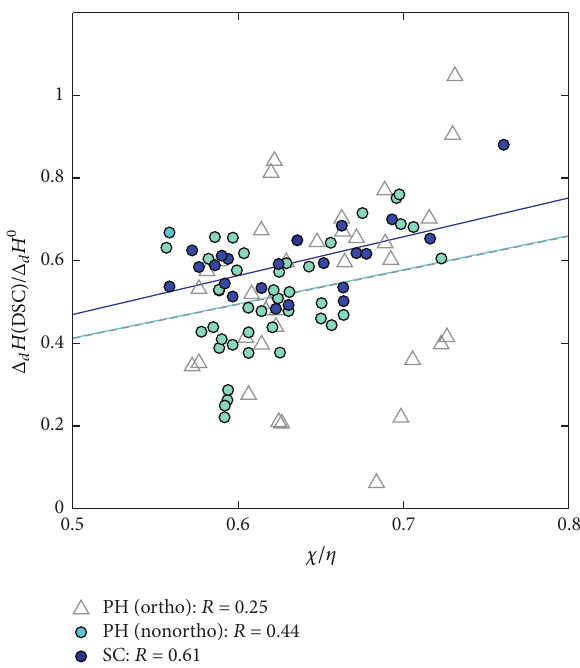
Figure 2: Correlations between 𝑓 and 𝜒/𝜂 . The regression line for SC data is shown in dark blue. Note that, for PH data, the corresponding lines for nonortho and ortho compounds are the sames (light blue/grey lines). The rightmost symbol stands for the SC value for picric